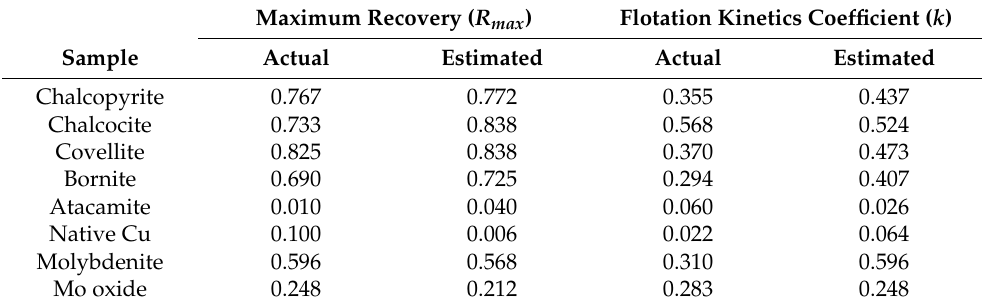
Table 11. Comparison of actual (Sample F) and estimated value on maximum recovery ( R max ) and flotation kinetics coefficient ( k ) for each